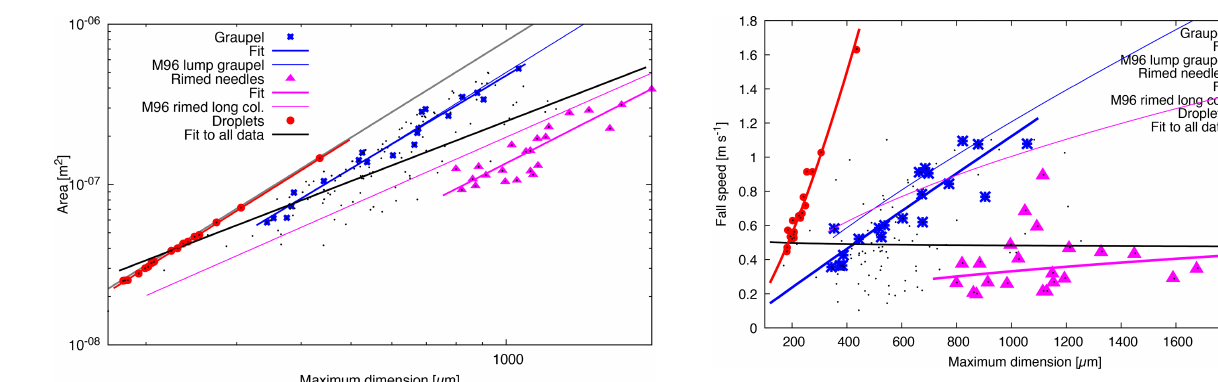
Figure 10. Area A versus maximum dimension D from snowfall measured on 19 October 2014 between approximately 06:00 and 19:00UTC. Fits to all data (black dots) and to three subsets corre- sponding to graupel, rimed needles, and droplets are shown as lines in the same colour as the corresponding data points. For compar- ison, a grey line indicates the cross-sectional area of spheres. In addition, two relationships reported by Mitchell (1996, referred to as M96 in the legend) are shown as thinner lines: one for rimed long columns (magenta) and one for lump graupel (blue).